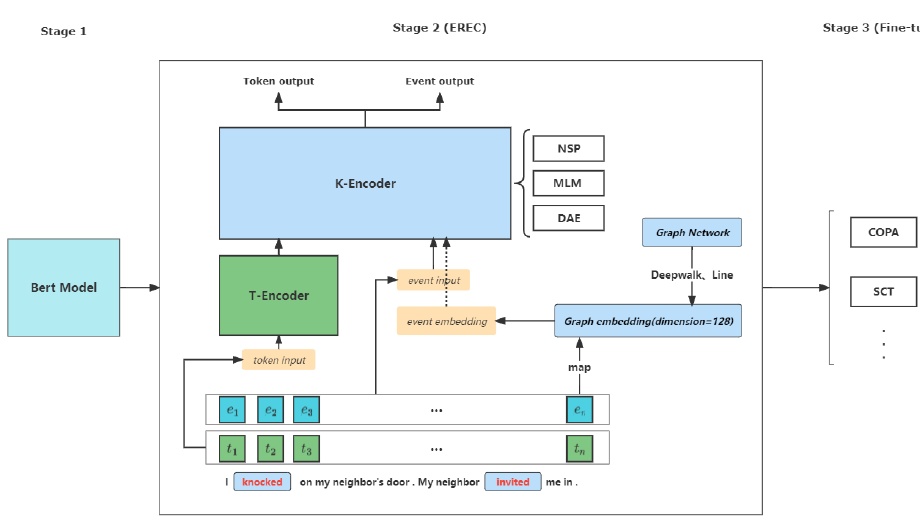
Figure 1. Model architecture and three-stage